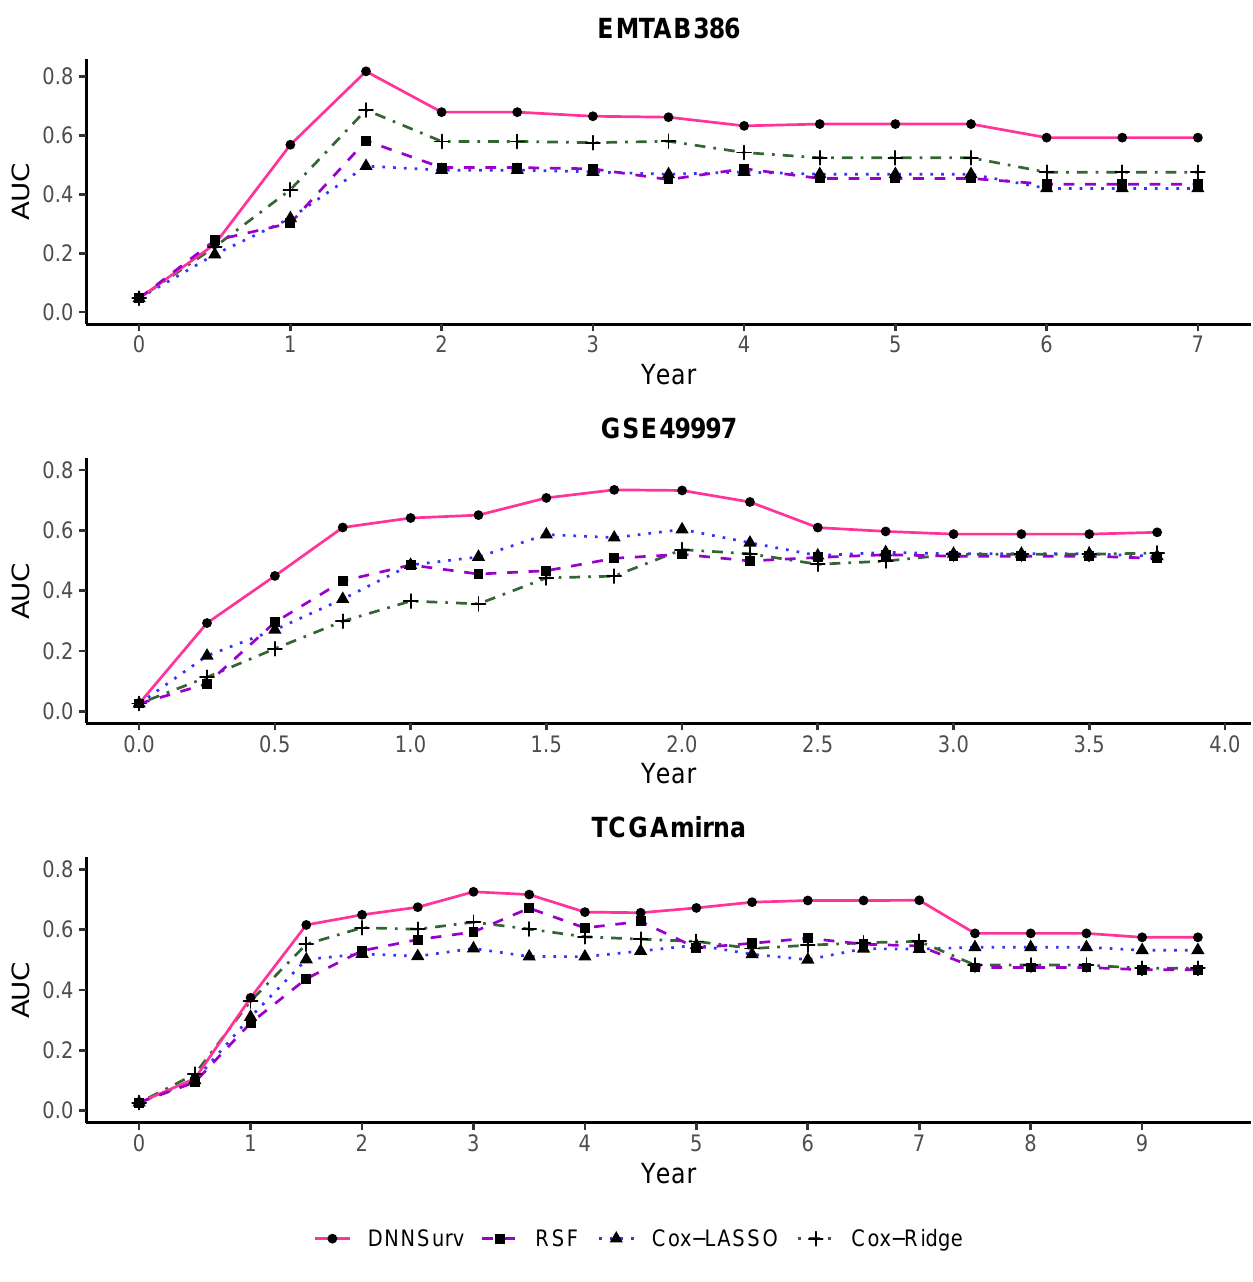
Figure 9. The time-dependent AUC for all four models on three test datasets that contain both gene and clinical variables (G +